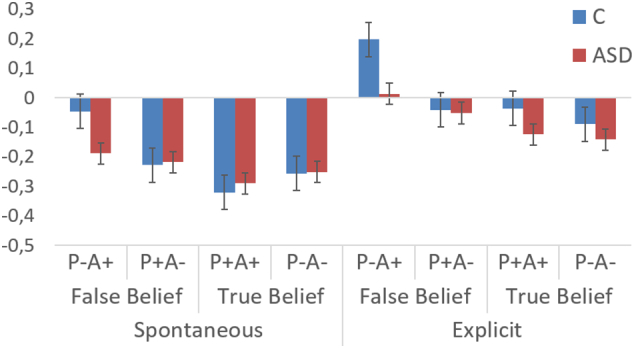
Extracted beta values for the ROI with coordinates (42, −67, 43), displayed per task version, per condition. Blue = Control group (C)·Red = ASD group. Error bars indicate ±1 standard error.